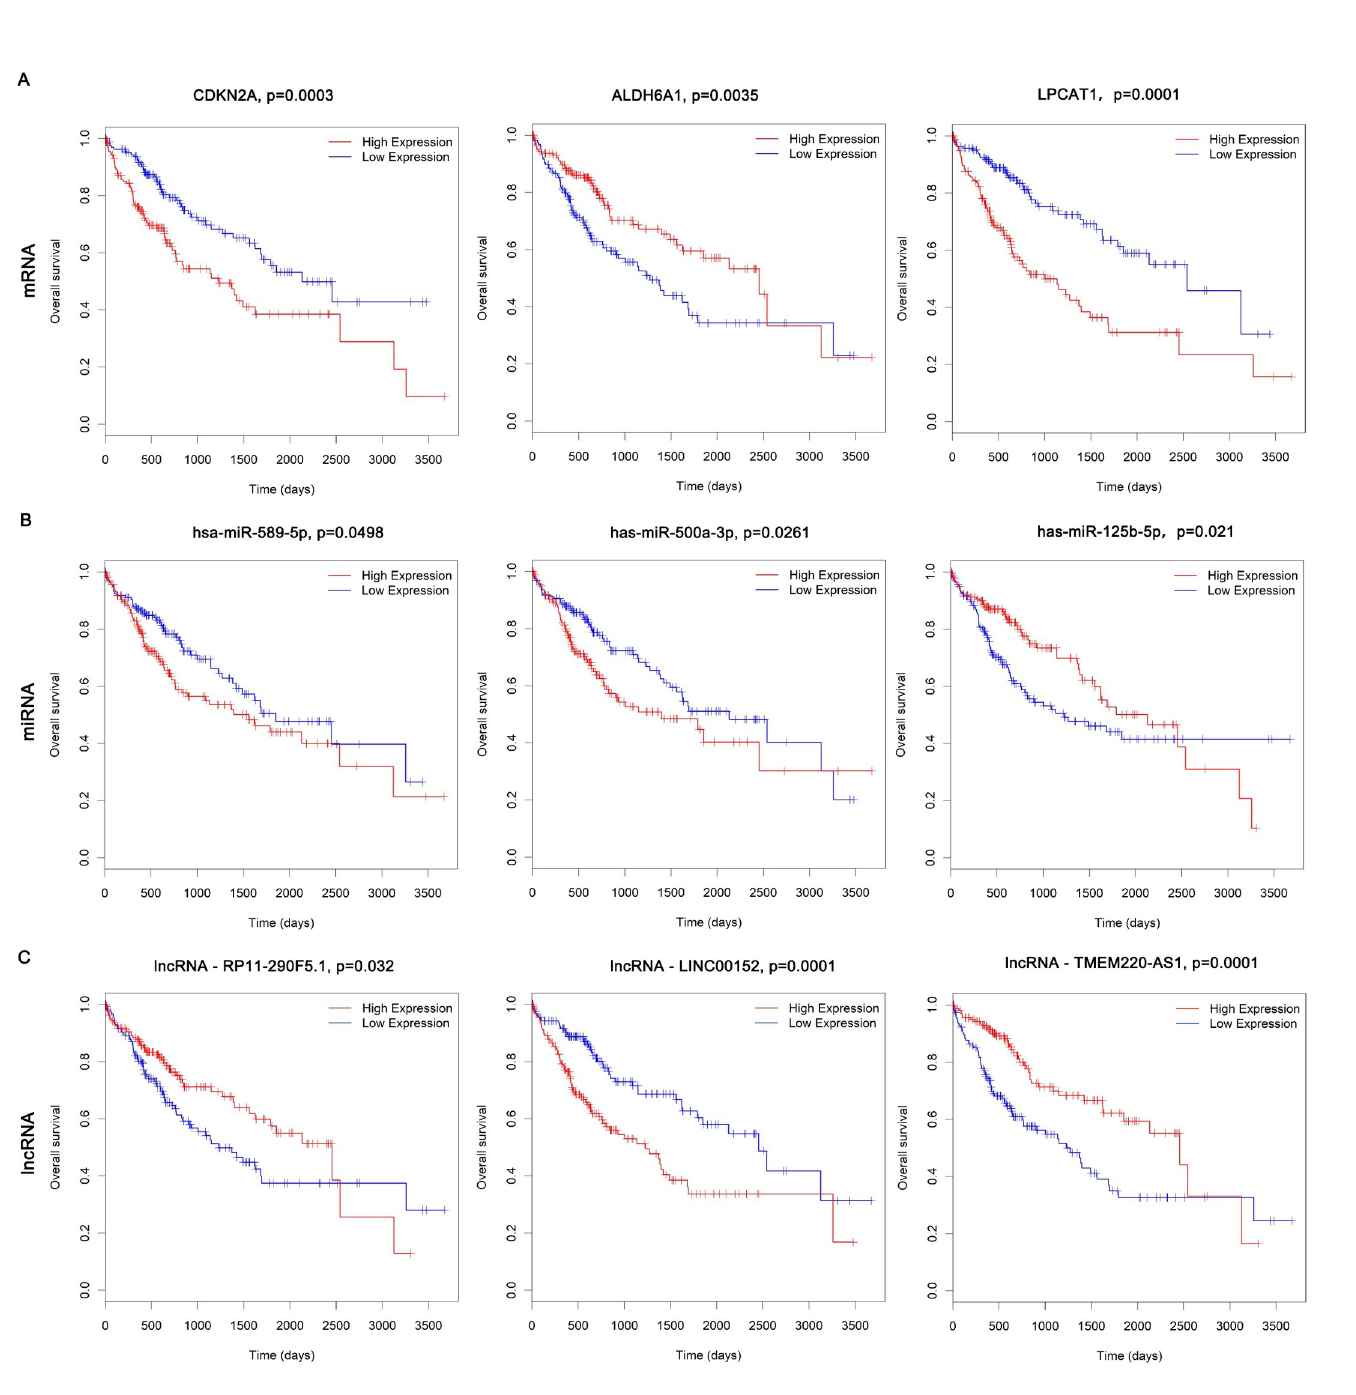
Fig 6. Kaplan-Meier curves of the 12 DERNAs associated with overall survival. (A) DEmRNAs associated with OS, (B) DEmiRNAs associated with OS, and (C) DElncRNAs associated with OS.